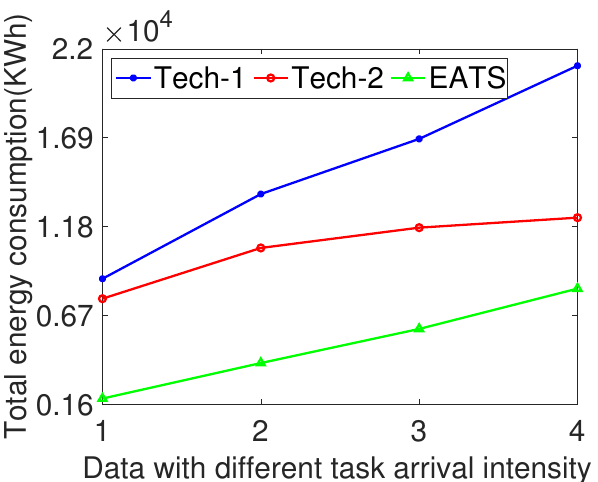
Figure 10. The influence of various task arrival intensities on the energy